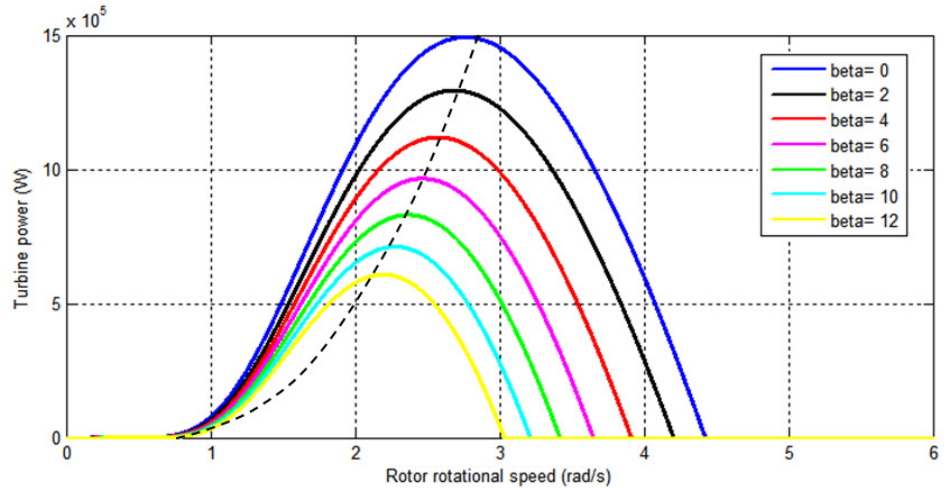
Figure 6. Output power versus the rotor speed for different blade pitch